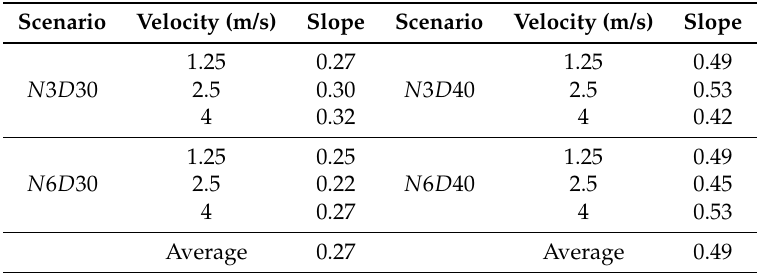
Table 5. Slopes corresponding to different velocities and scenarios.